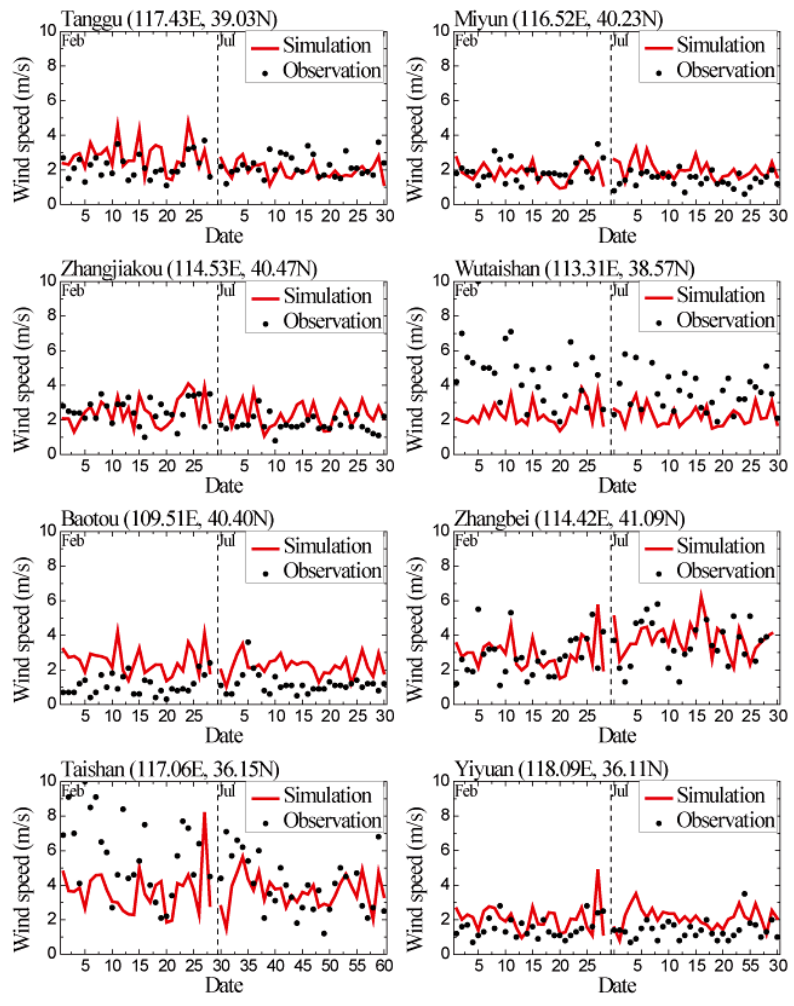
Figure 4. Same as Fig. 2 but for wind speed (ms − 1